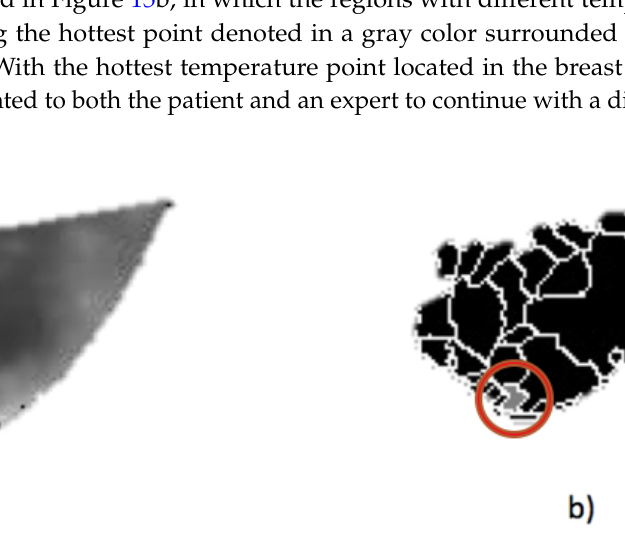
Figure 15. Breast cancer detection example: ( a ) segmented right breast thermogram; and ( b ) the result of watershed segmentation with the hottest spot detected in gray.